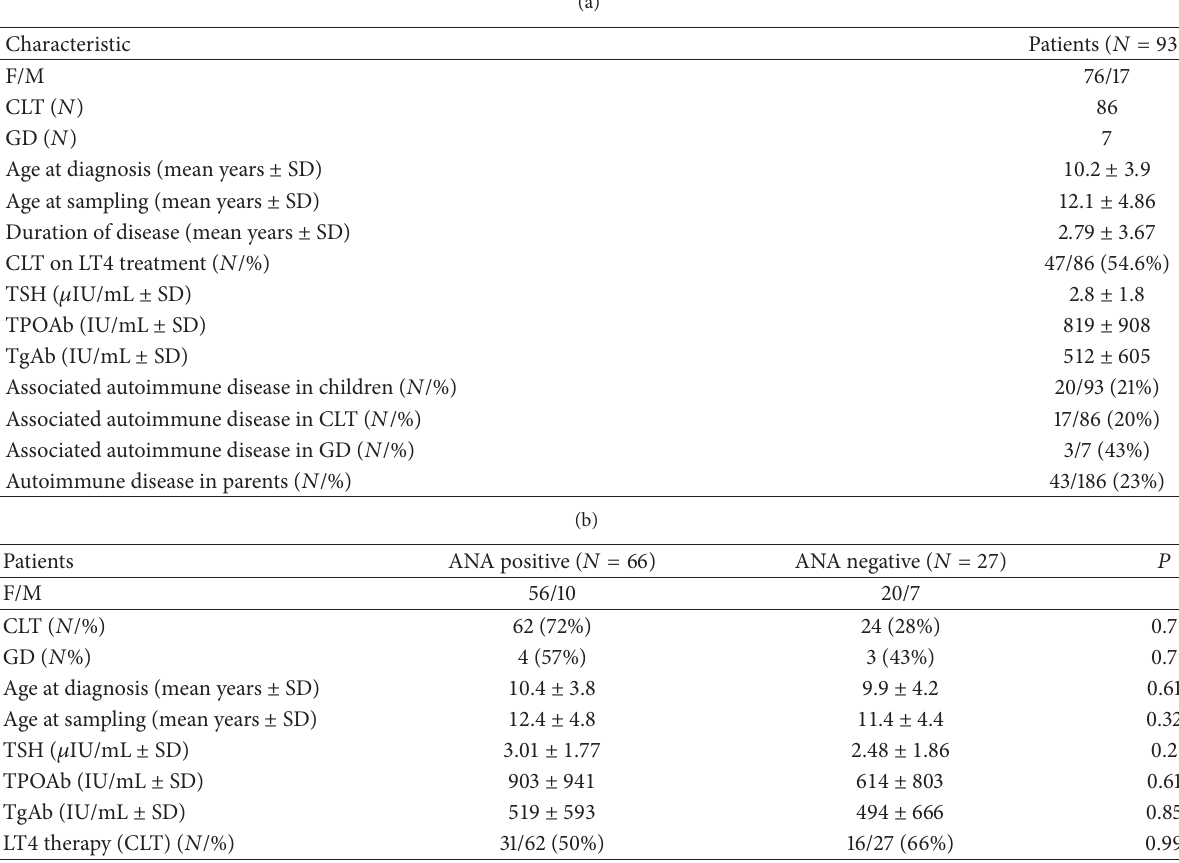
Table 1: (a) Clinical and laboratory features of the patients at inclusion. (b) Clinical and laboratory features of ANA-positive and ANA- negative